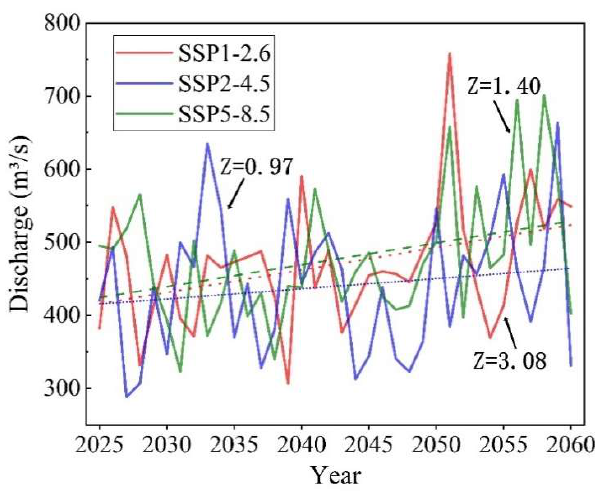
Figure 12. The annual discharge simulated by the calibrated SWAT model for 2025–2060 under the three emission scenarios.